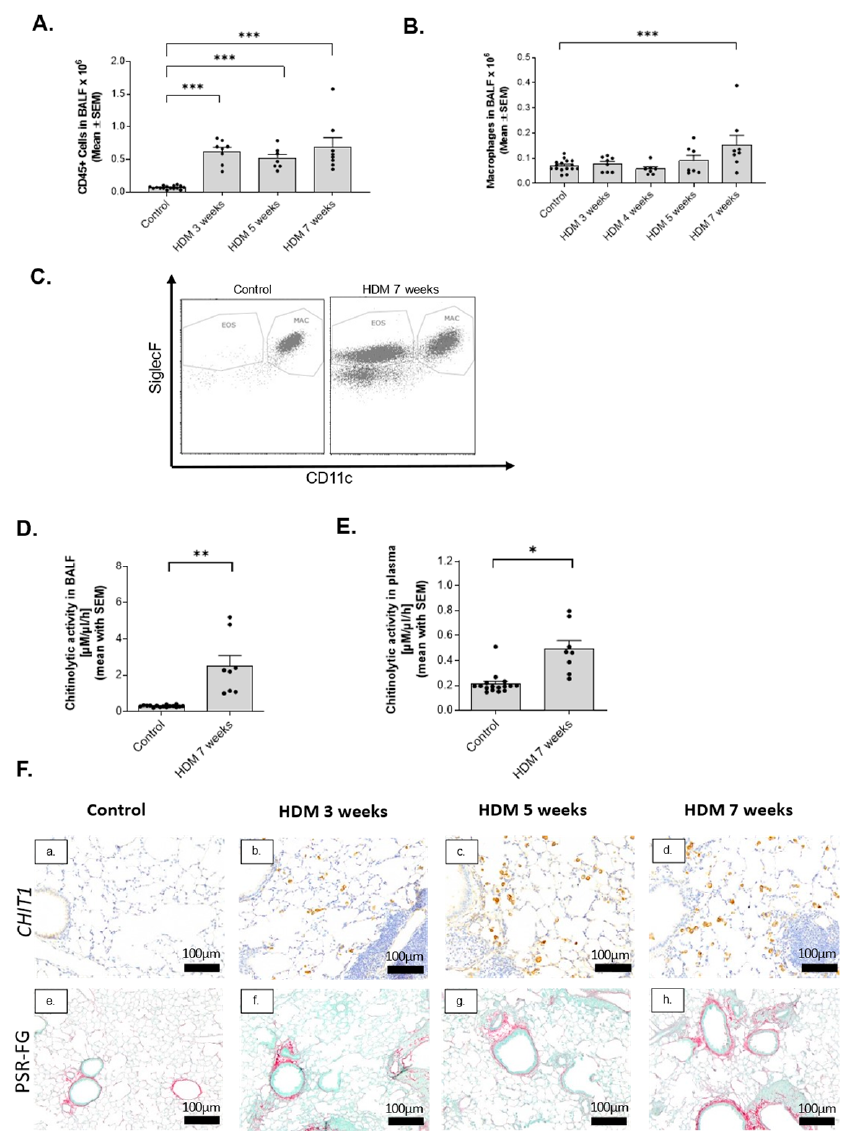
Figure 2. Activation of chitinases in chronic HDM-induced airway remodeling model in mice. ( A ) Number of total infiltrated leukocytes (CD45-positive cells) in BAL fluid analyzed by flow cytometry during progression of chronic airway remodeling at 3–7 weeks of HDM administration intranasally 5 times a week. ( B ) Flow cytometry analysis of alveolar macrophages (Siglec F+, CD11c+) represented as total macrophage numbers in BAL fluid (1 mL) tested after 3, 4, 5, and 7 weeks of HDM administration. ( C ) A representative dot plot of BALF-isolated CD45-positive cells (Siglec F+, CD11c+) representing alveolar macrophages. ( D ) Chitinolytic activity in BAL fluid and ( E ) plasma recovered from naïve mice challenged with PBS or HDM (7 weeks of administration). ( F , a – h ) Representative histological pictures of samples immunostained for CHIT1 ( a – d ) and picrosirius red–fast green ( e – h ) for collagen on mouse lungs; HDM-induced airway remodeling progression was followed at timepoints 3 weeks ( b , f ), 5 weeks ( c , g ), and 7 weeks ( d , h ) of intranasal administration of HDM. Control samples are presented on a and e panels. Data presented as mean ± s.e.m. p -values < 0.05 were considered as statistically significant and presented as * for p < 0.05, ** for p < 0.01, *** for p < 0.001.